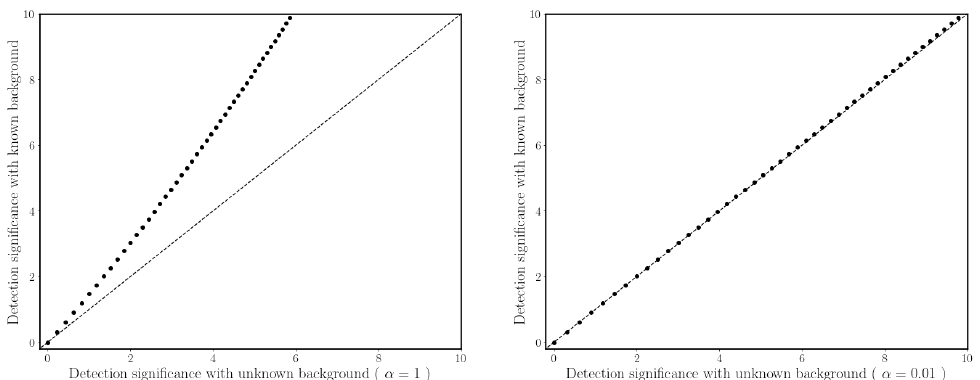
Figure 6. Comparison between the Li&Ma statistic in Equation (28) (x-axis) and the Cash statistic in Equation (24) (y-axis). In both plots, each point shows the significance for a different N on ranging from 10 (where the significance is zero in both cases) to 56. For the Cash formula ¯ b is fixed to 10 in both plots, while for the Li&Ma formula N of f is 10 with α = 1 in the left plot, and N of f = 1000 with α = 0.01 in the right plot. As a reference the equation y = x (dashed line) is shown. One can see that the Li&Ma statistic converges to the Cash one when α (cid:28)